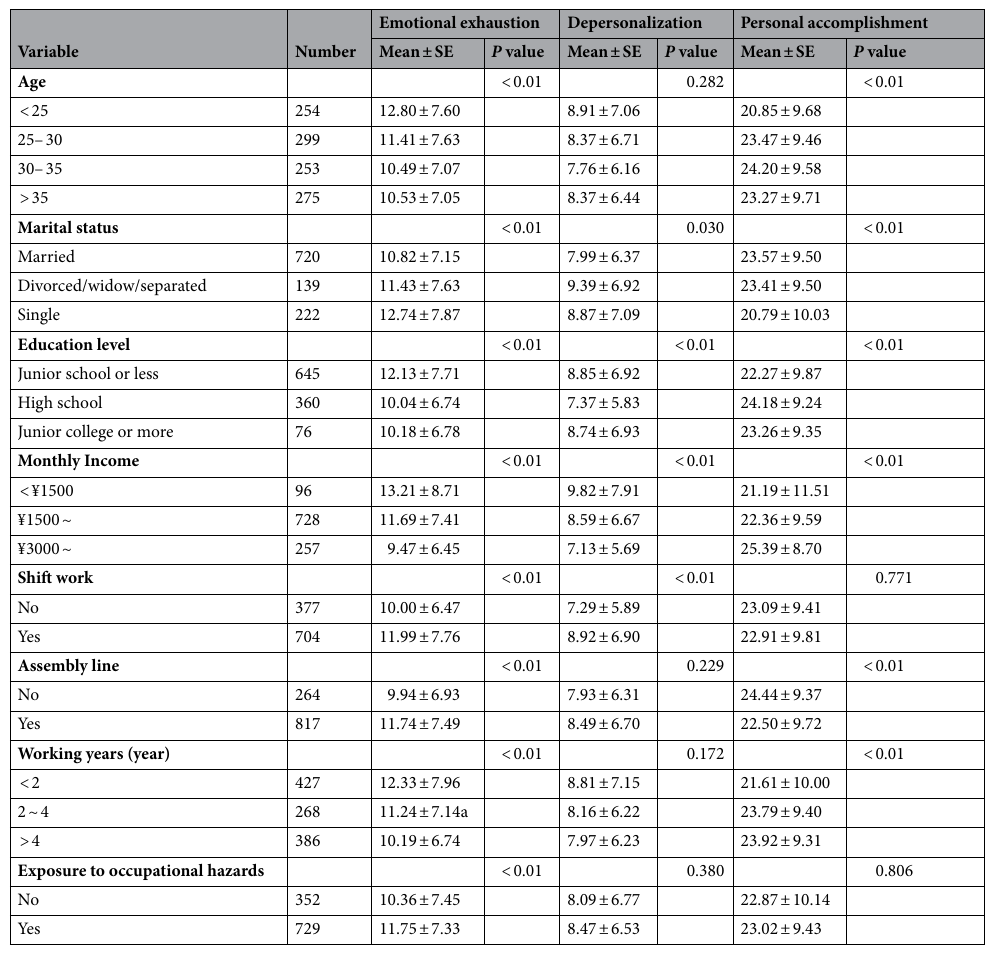
Table 2. Univariate analysis of MBI-GS scores according to demographics and work characteristics.